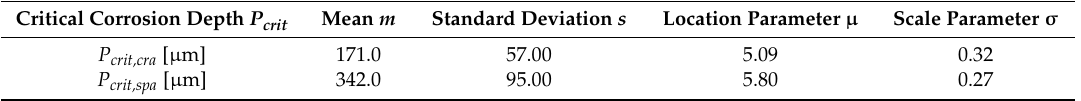
Table 6. Critical corrosion depths P crit linked to the events of cracking and spalling, according to data presented in